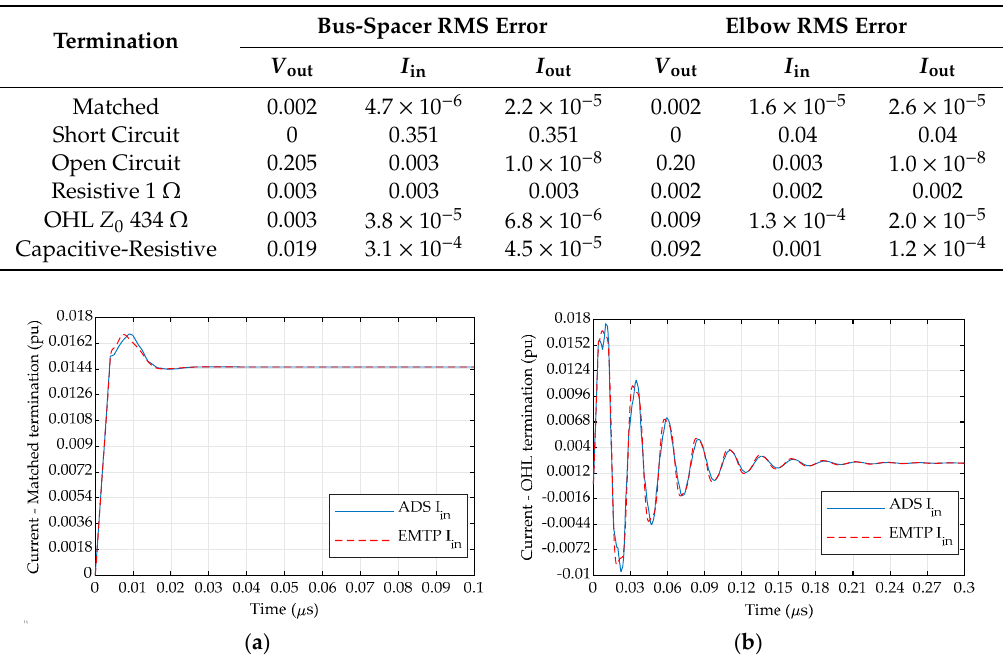
Figure 7. EMTP vs. ADS elbow transient responses showing good agreement for: ( a ) matched termination; and ( b ) OHL termination.